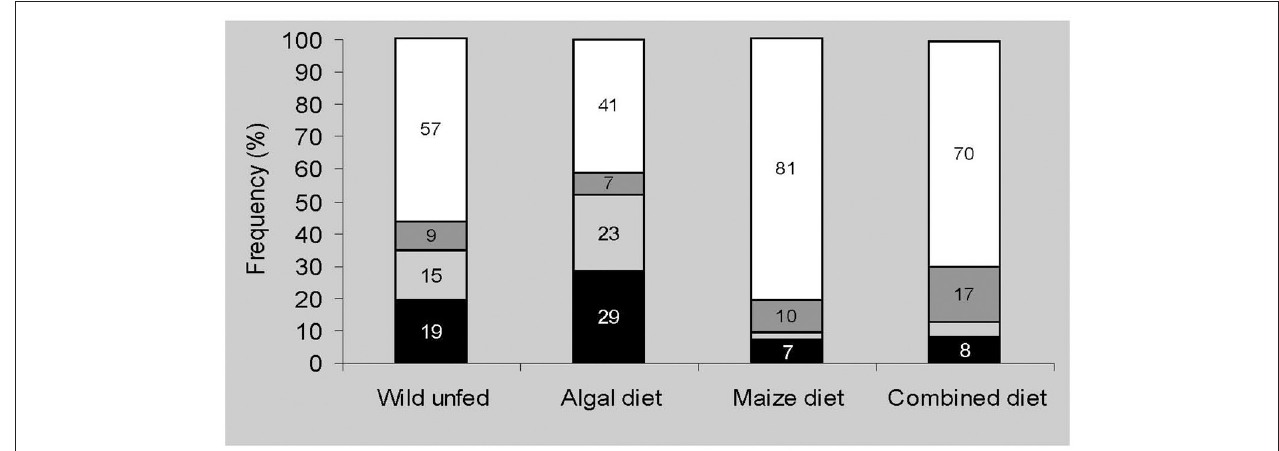
FIGURE 3 | Nutritional state effects of sea urchins on the response toward food-related compounds soaked in simulacra. Black bars represent frequencies of carried simulacra-containing stimulus, light grey bars represent carried blank simulacra, dark grey bars represent discarded simulacra, and white bars represent unresponsiveness ( N = 150 sea urchins under each dietary regime). For every diet, five food-related compounds were tested [glucose, starch, sucrose, olive oil, amino acid (AA) mixture] and expressed as their pooled responses. TABLE 1 | Selection of absorbent cleaning